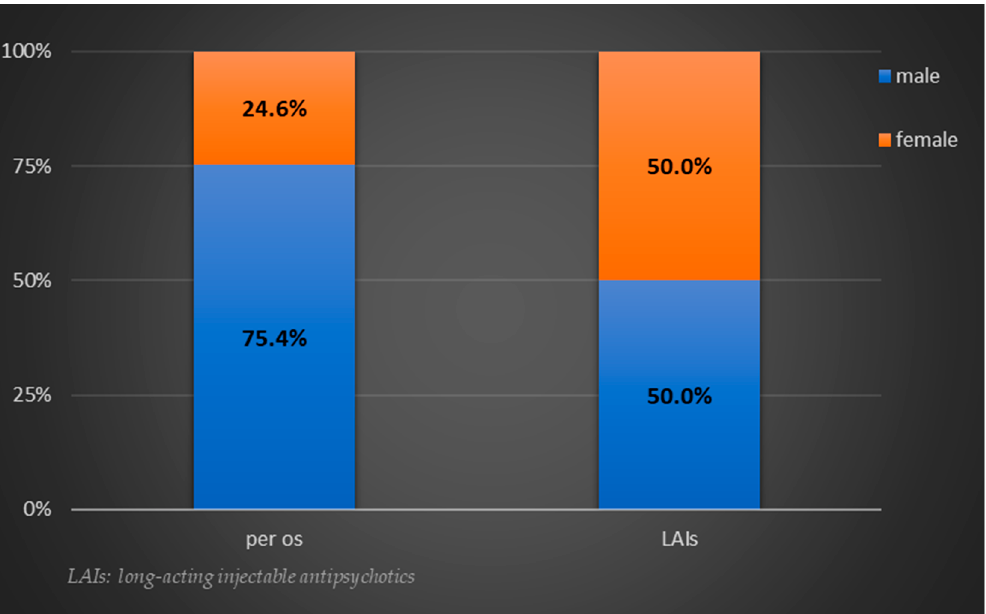
Figure 1. Percentage distribution of biological sex per group of antipsychotic formulation.